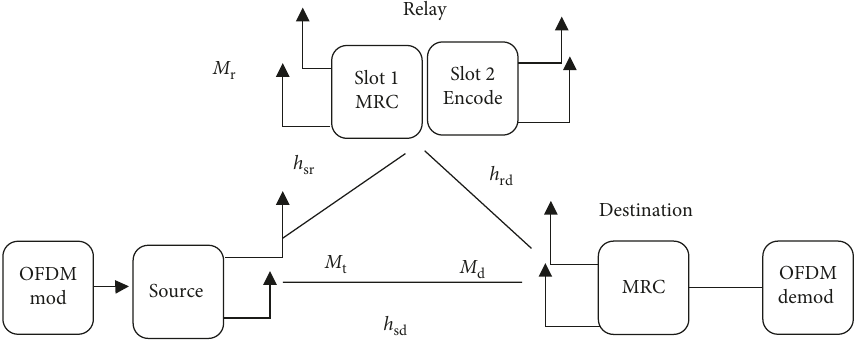
Figure 2: System model (MIMO-OFDM with relay nodes). Table 1: Simulation parameters of OFDM-MIMO relay